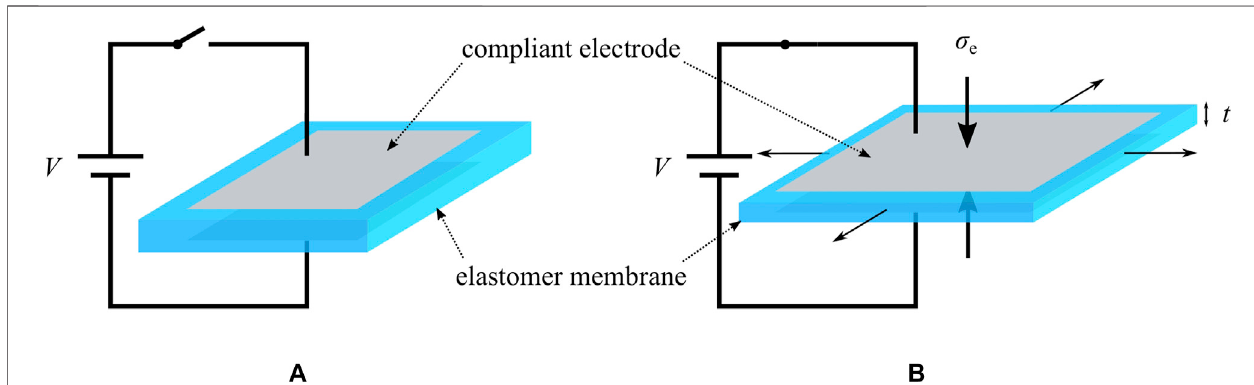
FIGURE 1 | Basic principle of a dielectric elastomer. (A) The membrane is initially undeformed. (B) When a high voltage is applied to the compliant electrodes, the silicone membrane gets thinner and expands in area.